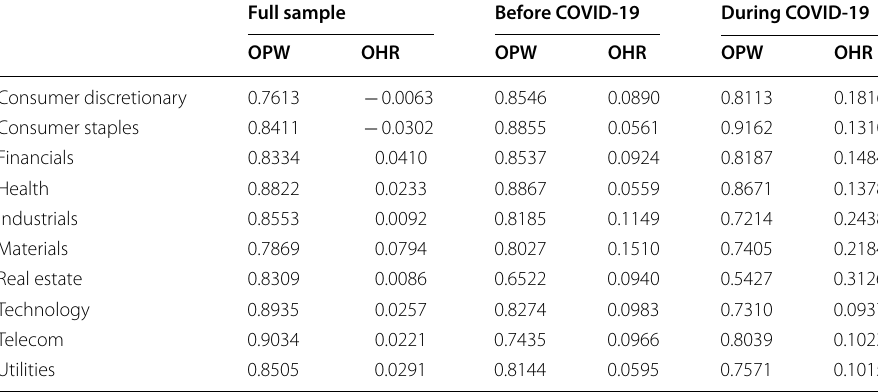
Table 5 Optimal portfolio weights and hedge